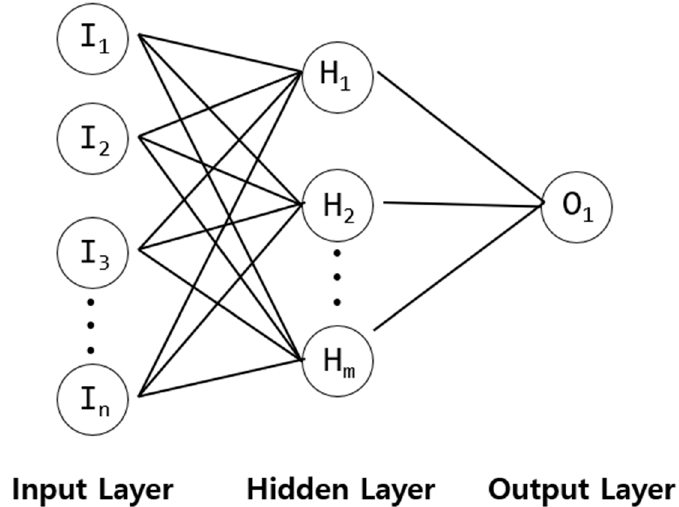
Figure 3. The designed network diagram for artificial neural network (ANN).